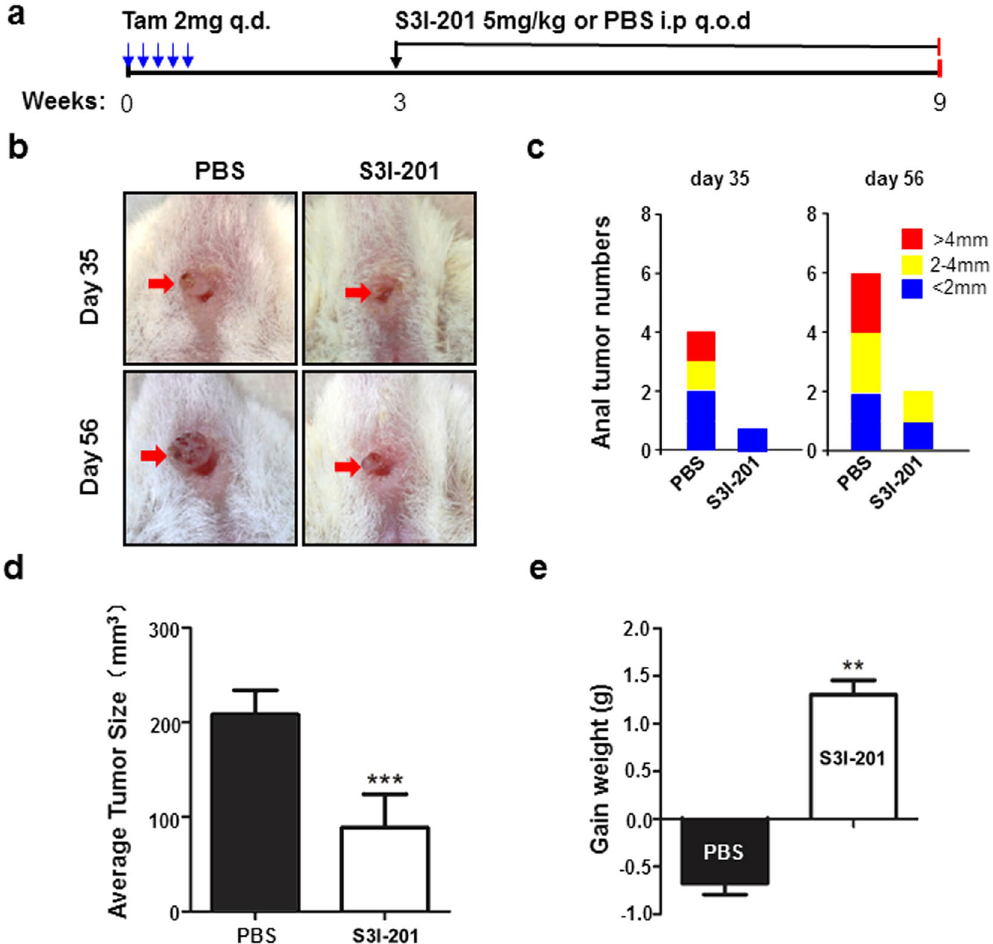
Figure 3. S3I-201 treatment protected mice from tumor challenge. ( a ) A schematic flow chart showed the drug delivery strategy of S3I-201 in the chemopreventive tumorigenesis experiment in Tgfbr1/Pten 2cKO mice. ( b ) Pictures of visible tumors were photographed at day 35 and day 56 in control group and S3I-201 chemopreventive group. The number of mice with ASCC ( c ) or the average sizes of tumor ( d ) were significantly reduced after S3I-201 treatment. And mice in the S3I-201 treatment group did not suffer from extra body weight loss ( e ), which is an indicator of drug toxicity. ** P < 0.01; *** P <